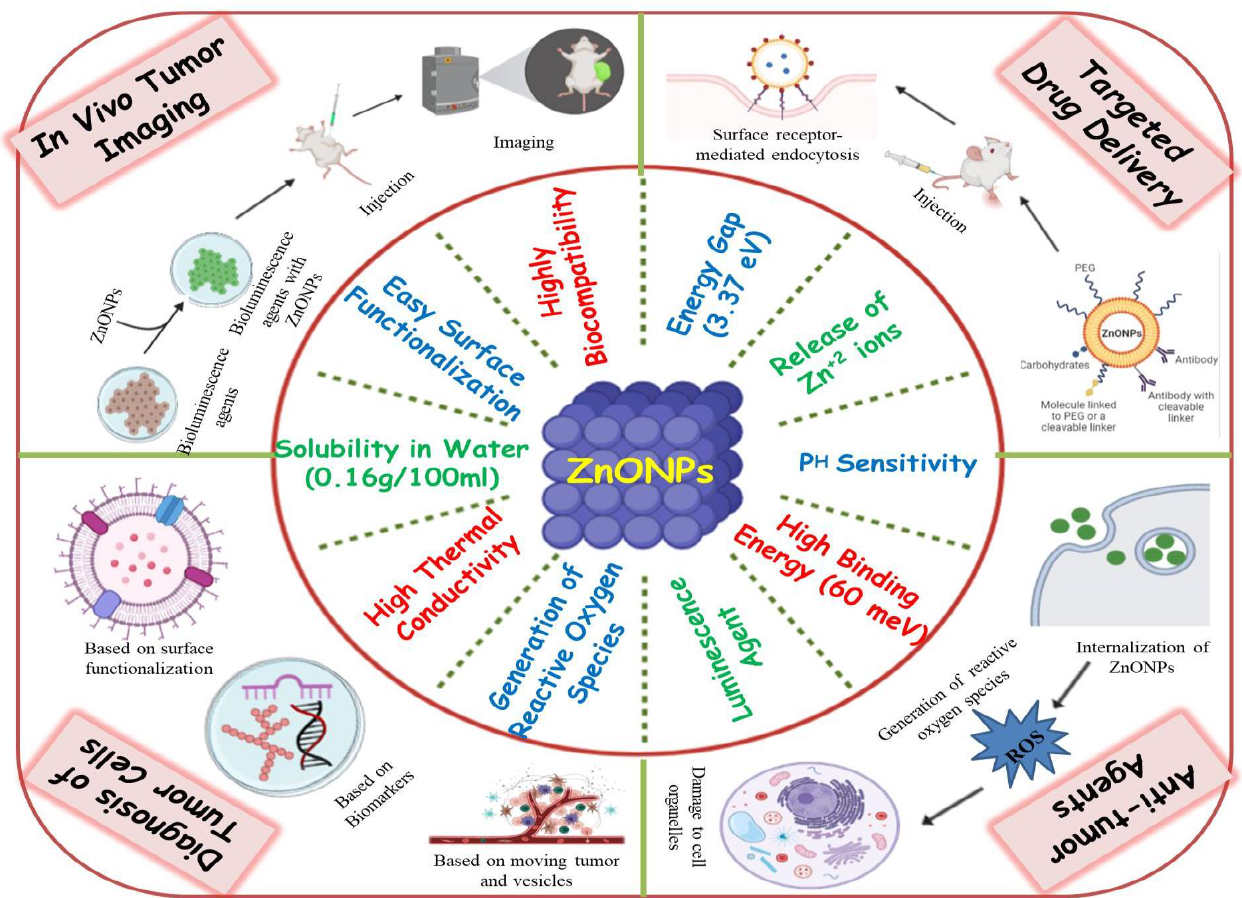
Figure 3. Graphical representation of the unique attributes of ZnO NPs and their various applications in fighting cancer.